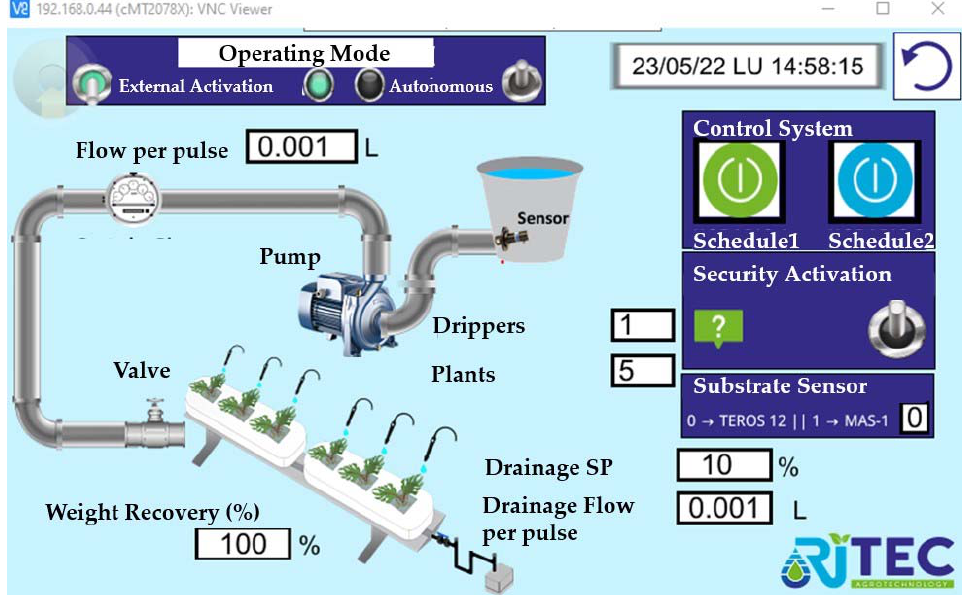
Figure 11. Screenshot example of HMI Operator’s panel.